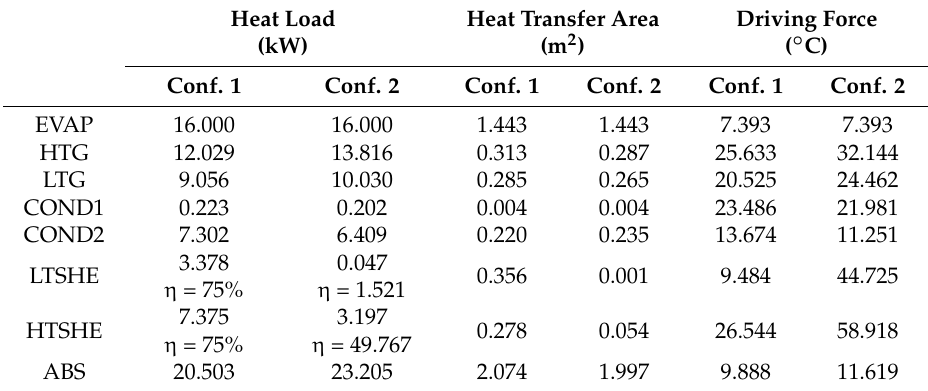
Table 2. Optimal values of heat transfer areas, heat loads, and driving forces obtained for configurations Conf. 1 and Conf. 2 for a cooling capacity of 16 kW.